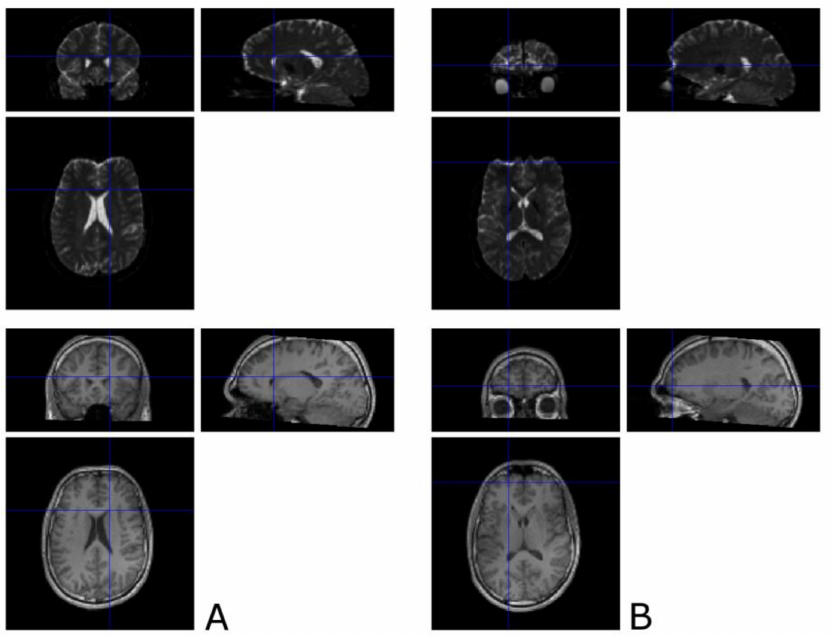
Figure A1. Visual inspection of registration quality (DWI: diffusion weighted imaging, T1) using the CheckReg tool implemented in Statistical Parametric Mapping (SPM) comparing the location of several anatomical landmarks such as the edge of the ventricles ( A ), showing a good match, and the frontal border ( B ) within the DWI data, showing a slight mismatch in the T1-weighted data sets due to non-linear distortions within the DWI data. This mismatch will be compensated for by the definition and enlargement of regions of interest for fiber